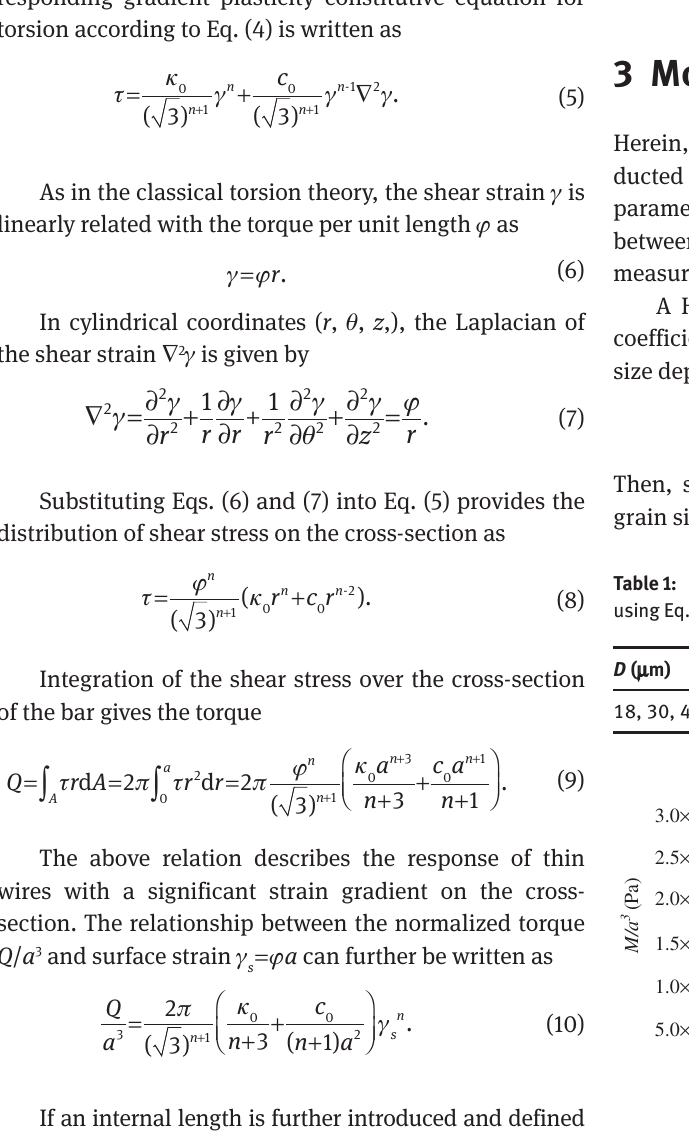
Figure 1: Comparison between the theoretical predictions of Eq. (10) (lines) and the experimental data of Liu et al. [10] (points).